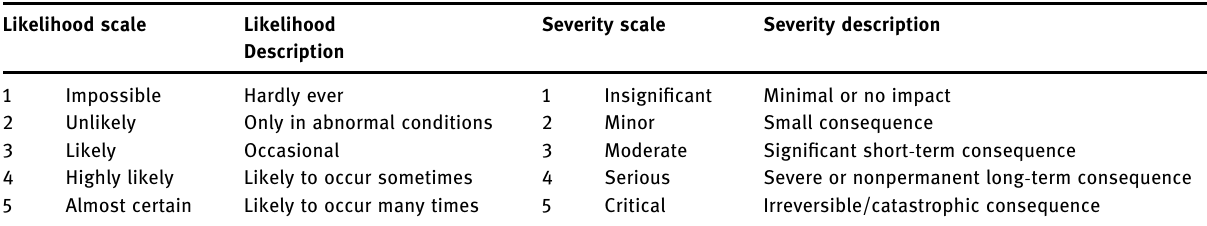
Table 1: Description of likelihood and severity scales